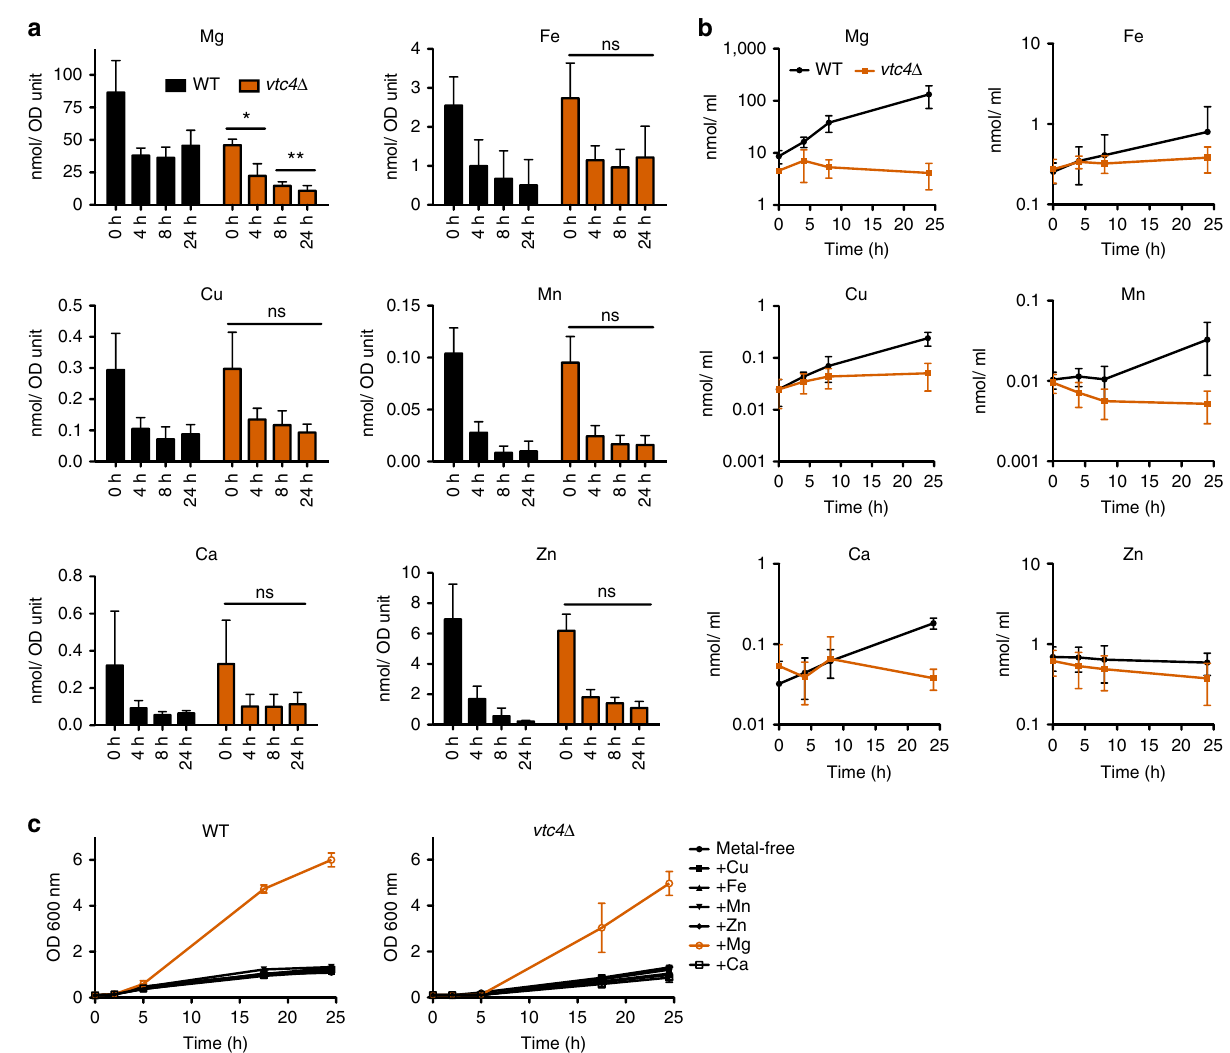
Fig. 3 Metal extraction from YPD/EDTA. Time-course ICP-MS analysis. Cells were pre-cultured on YPD and transferred to YPD/EDTA. At the indicated time points, aliquots were withdrawn, cell density was determined, the cells were sedimented and their content of magnesium, iron, zinc, copper, manganese and calcium was measured. a Values per OD 600 nm unit of cells and ( b ) the values per culture volume, which allows to judge whether there is net transfer of metal from the medium into the accumulating biomass. c Growth on YPD/Chelex medium. Wild-type and vtc4 Δ cells were pre-cultured for 5 h on YPD/EDTA and transferred to YPD/Chelex medium supplemented with the indicated metal to fi nal concentrations that are suf fi cient to support vigorous continuous growth of non-depleted wild-type cells: 0.25 μ M CuSO 4 ; 1.2 μ M FeCl 3 ; 2.6 μ M MnSO 4 ; 2.5 μ M ZnSO 4 ; 0.9 mM CaCl 2 ; 4.2 mM MgSO 4 . The OD 600nm was measured at the indicated time points after transfer. a – c Results represent mean ± SD of at least three independent experiments. Statistical differences in a were determined using Student ’ s t test comparing vtc4 Δ and wild-type cells at each time point; * p ≤